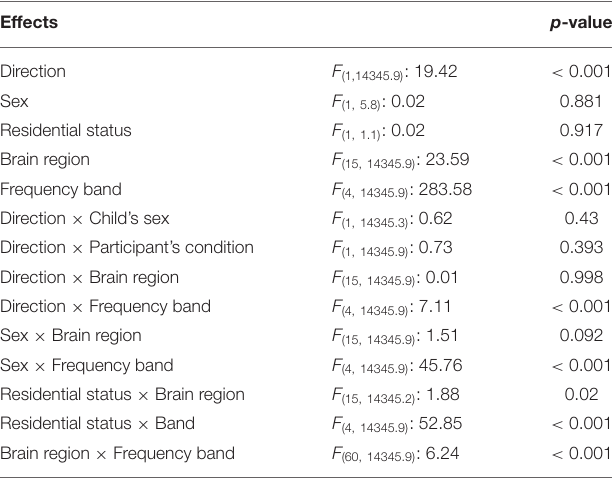
TABLE 6 | F-statistics and p -values from the linear mixed model of the effect of direction of influence, child’s sex, condition, brain region, frequency band, and interactions thereof, on the observed Granger